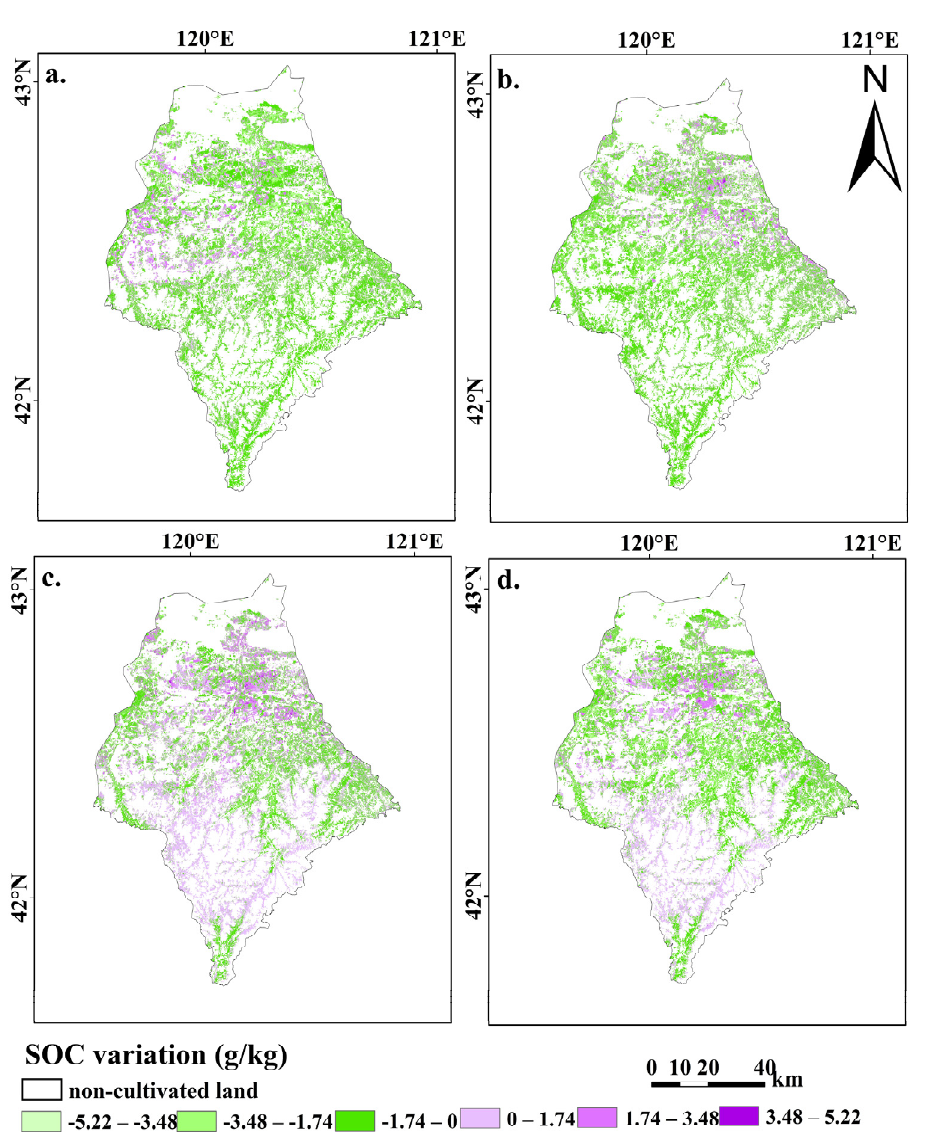
Figure 5. Spatial pattern of the changes in soil organic carbon (SOC) during the periods of 1989– 2001 ( a ), 2001–2009 ( b ), 2009–2018 ( c ) and 1989–2018 ( d